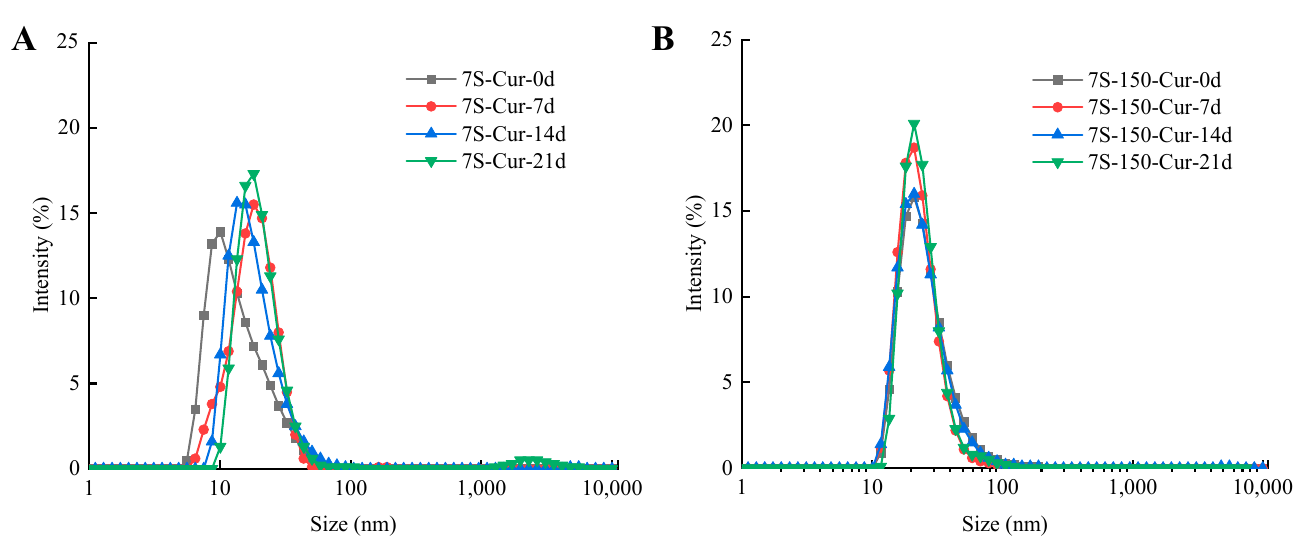
Figure 7. Changes in the particle size of the 7S-Cur ( A ) and 7S-150-Cur ( B ) nanocomplexes during the storage time (0–21 days). 7S: soy β -conglycinin; 150: dextran (150 kDa); Cur: curcumin.